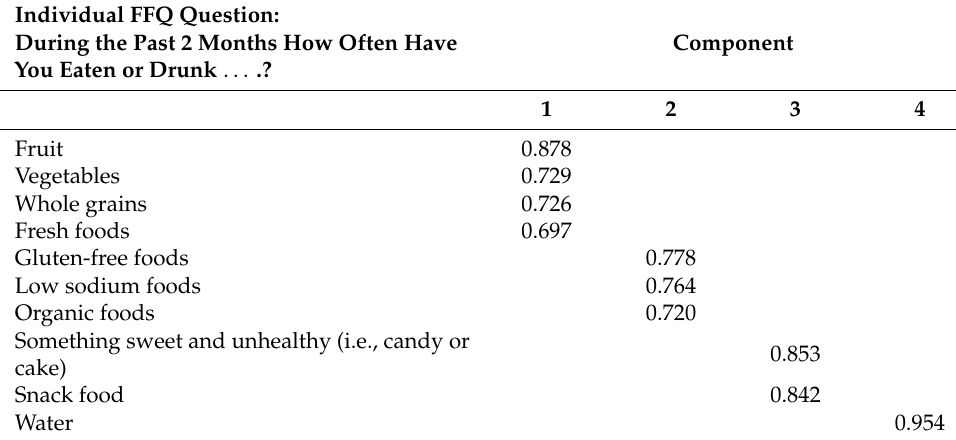
Table 6. Extraction of four principal components from the FFQ: rotated component matrix a . Individual FFQ